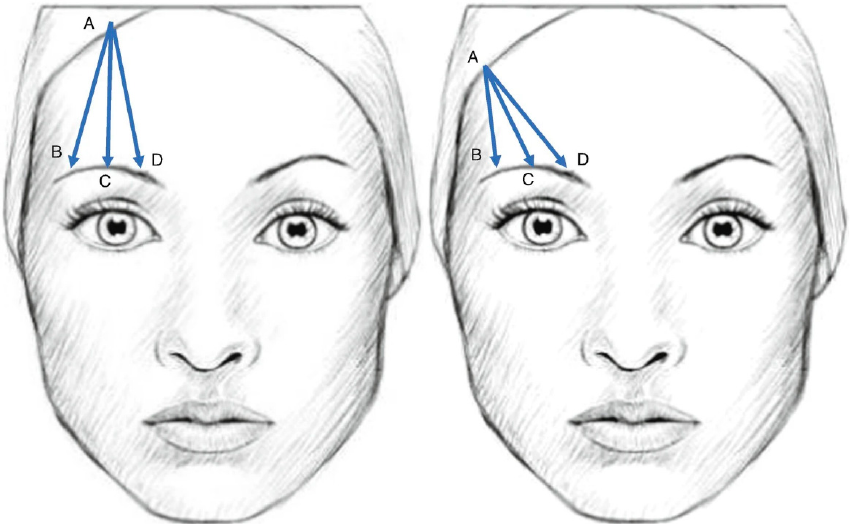
Figure 18. The use of unidirectional cogged threads for eyebrow central elevation (left) and lateral elevation (right). (A) de-note the entry point and (B), (C) and (D) denote the anchoring points. Reprinted with permission from Ref. [116] .